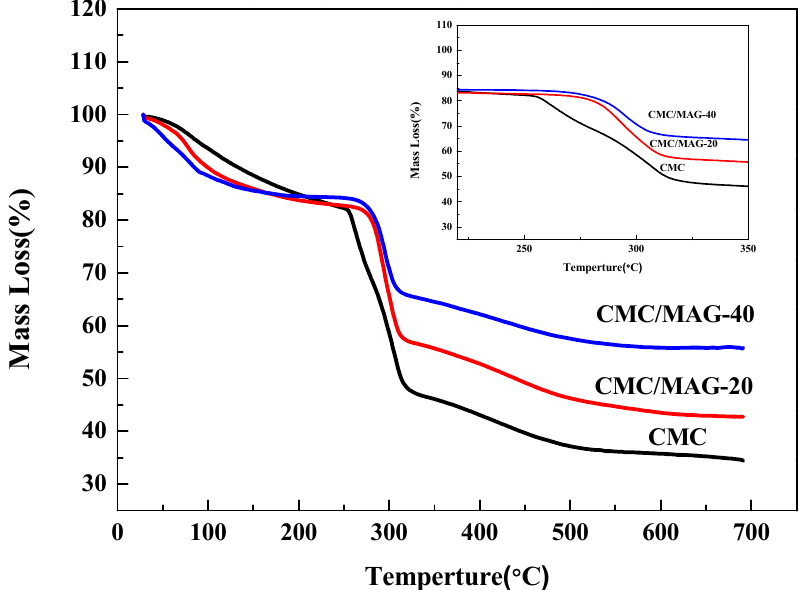
Figure 4. TG curves of CMC (curve black), CMC/MAG–20 (curve red) and CMC/MAG–40 (curve blue).